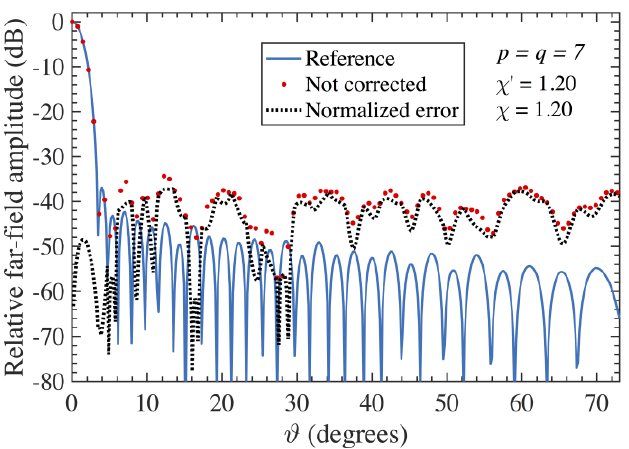
Figure 11. FF patterns in the E-plane — AUT 1. Blue line: reference. Red dots: attained from the positioning errors affected PWMS samples without using the proposed procedure. Dashed line: corresponding normalized error.